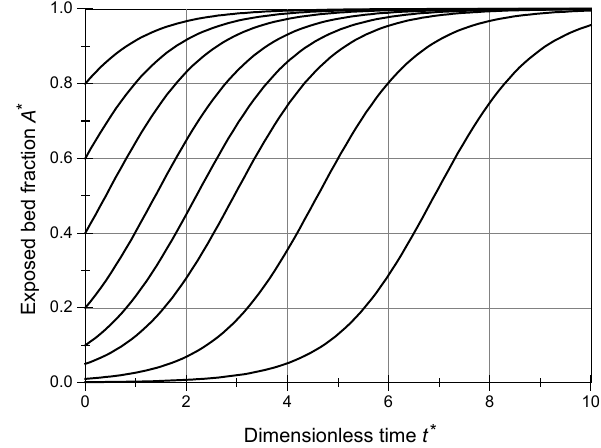
Figure 10. Temporal evolution of cover for the simple case of a Figure 11. Evolution of the exposed bed fraction (removal of sed- control box with sediment through-flux, based on Eqs. (3), (22), iment cover) over time starting with different initial values of bed (23), and (24). Relative sediment supply (supply normalized by exposure, for the special case of no sediment supply; i.e. q ∗ s = 0 transport capacity) was specified to 0.25 and increased to 1 at (Eq. 41) and q ∗ t = t ∗ = 5. The response of sediment output, mobile and stationary sed- iment mass, and the exposed bed fraction was calculated. Here, we = U ∗ = 1. The used the exponential function for P (Eq. 8) and M ∗ 0 initial values were A ∗ = 1 and M ∗ m = M ∗ s = 0.